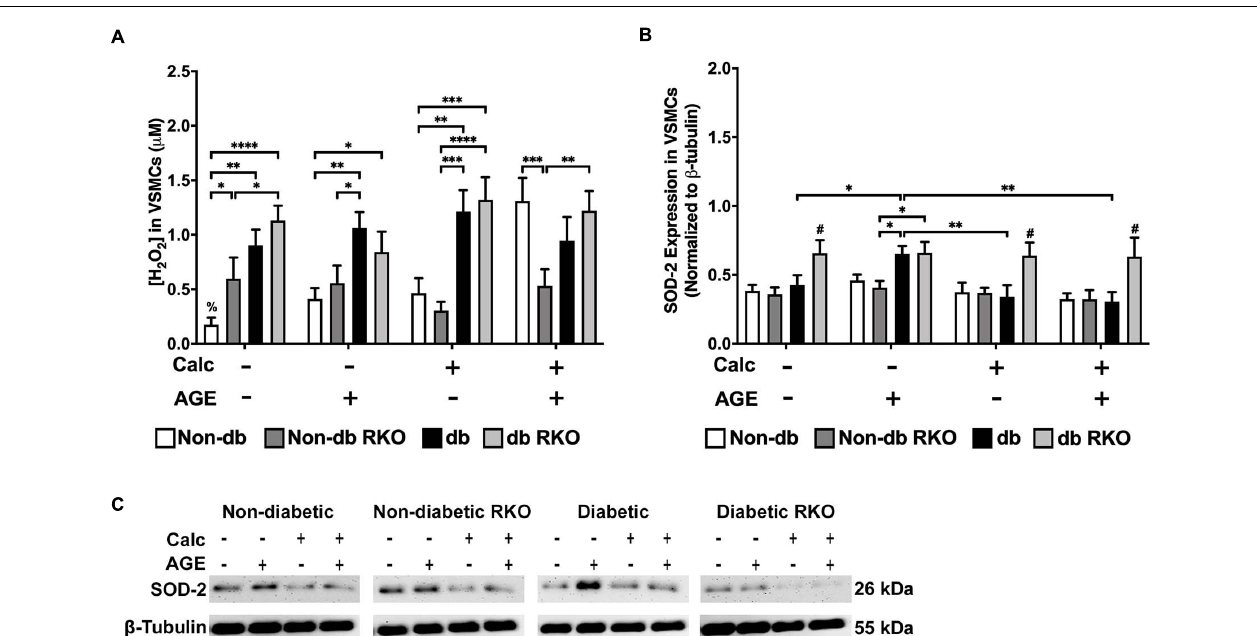
FIGURE 4 | The concentration of H 2 O 2 was increased due to calcification in VSMCs and SOD-2 expression was increased due to AGEs in diabetic VSMCs. The concentration of H 2 O 2 was measured colorimetrically (A) . Protein expression of SOD-2 (26 kDa; B ) was quantified. Non-diabetic, non-diabetic RKO, and diabetic, and diabetic RKO primary VSMCs were isolated and treated with 3 mM P i with or without AGEs (0.5 mg/mL) for 7 days. Protein levels were normalized to β -tubulin (C) and graphed as mean ± SEM with n = 6–9 of independent replicates. Statistical analysis consisted of a two-way ANOVA and a Fisher’s LSD test post hoc ( # p < 0.05 toward all other groups in treatment group, % p < 0.05 toward all other treatments within genotype, * p < 0.05, ** p < 0.01, *** p < 0.001, **** p <